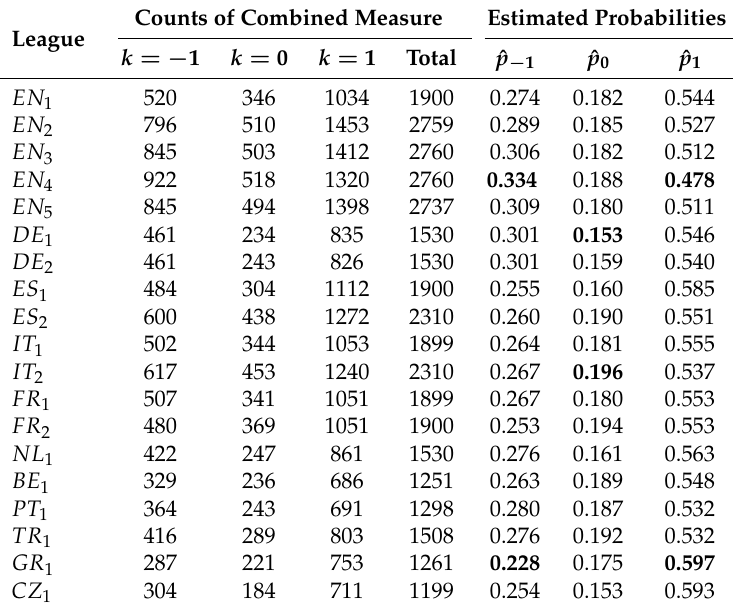
Table 4. Observed counts of combined measure for each analysed league over all 10 seasons with appropriate estimated